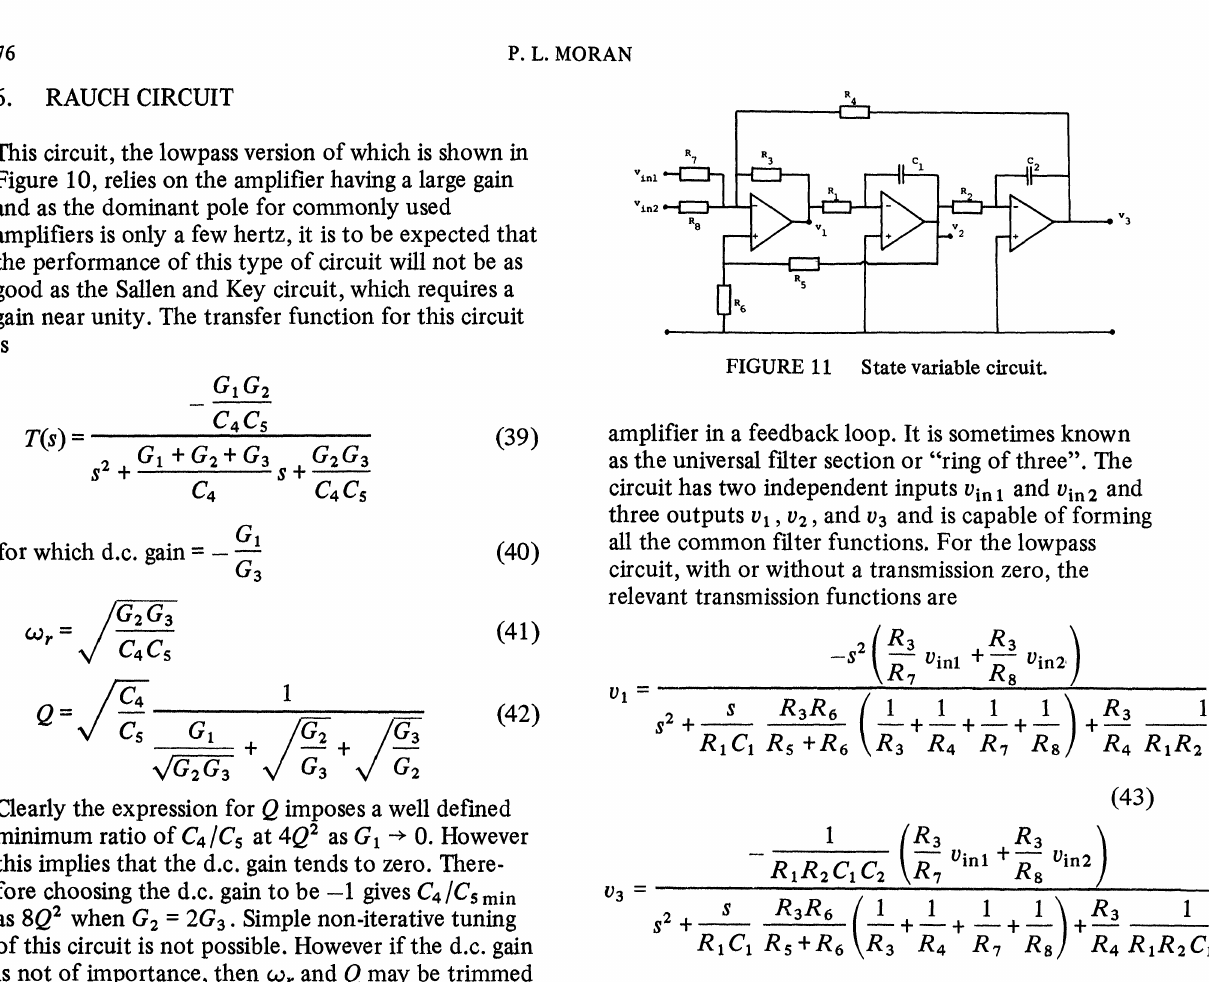
FIGURE 10 Rauch lowpass circuit.